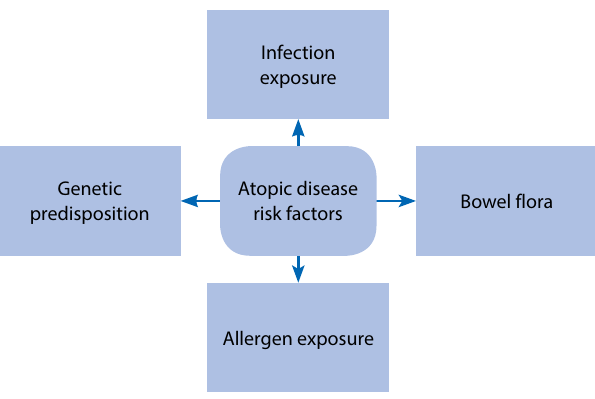
Figure 2 : Risk factors of developing atopy.